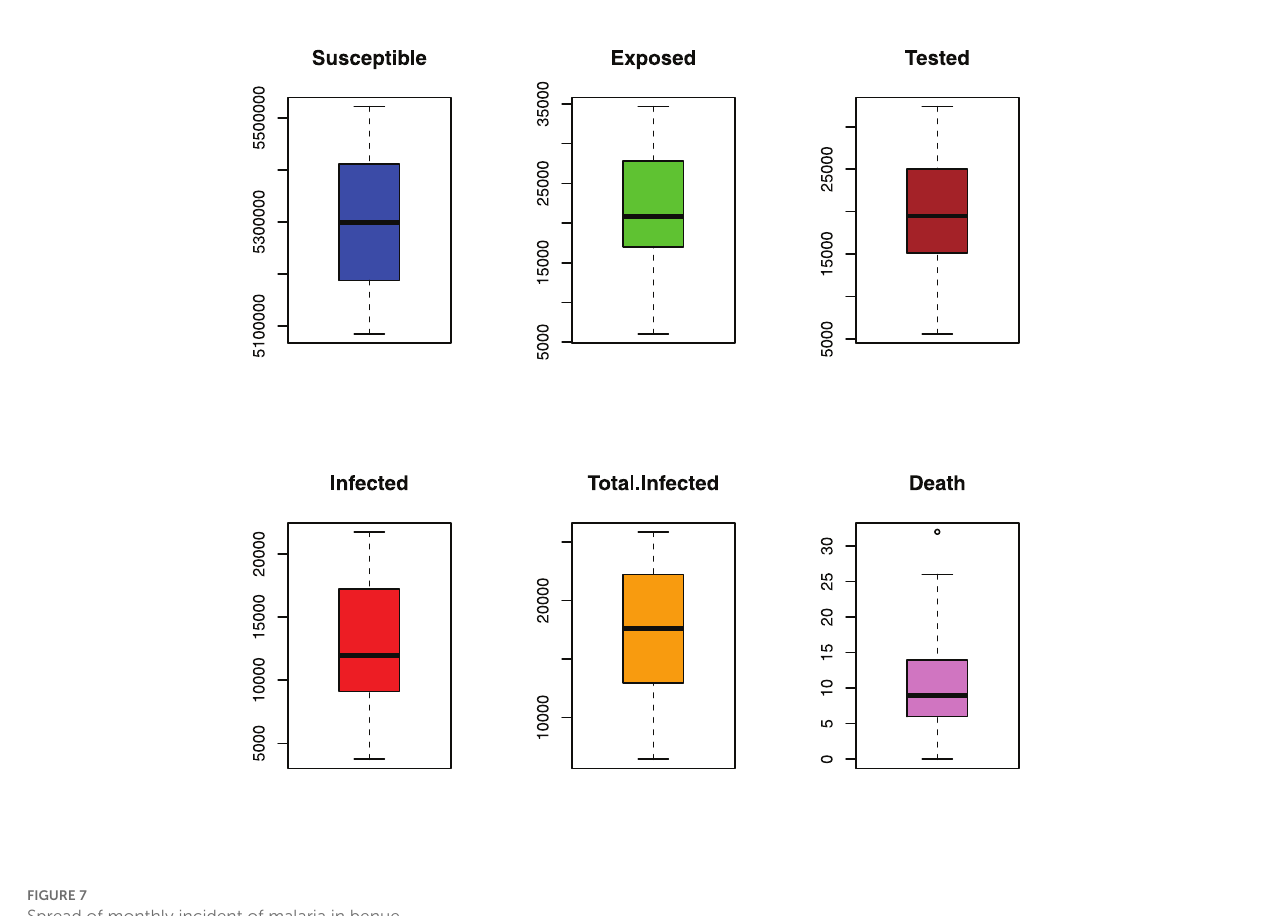
FIGURE7 Spread of monthly incident of malaria in